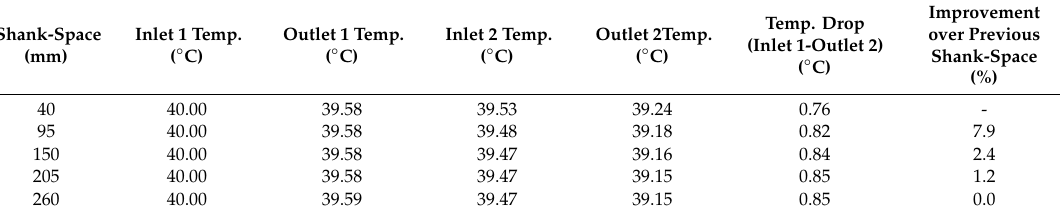
Table 2. Simulation results for di ff erent shank-spaces for the 20 m borehole. Shank-Space